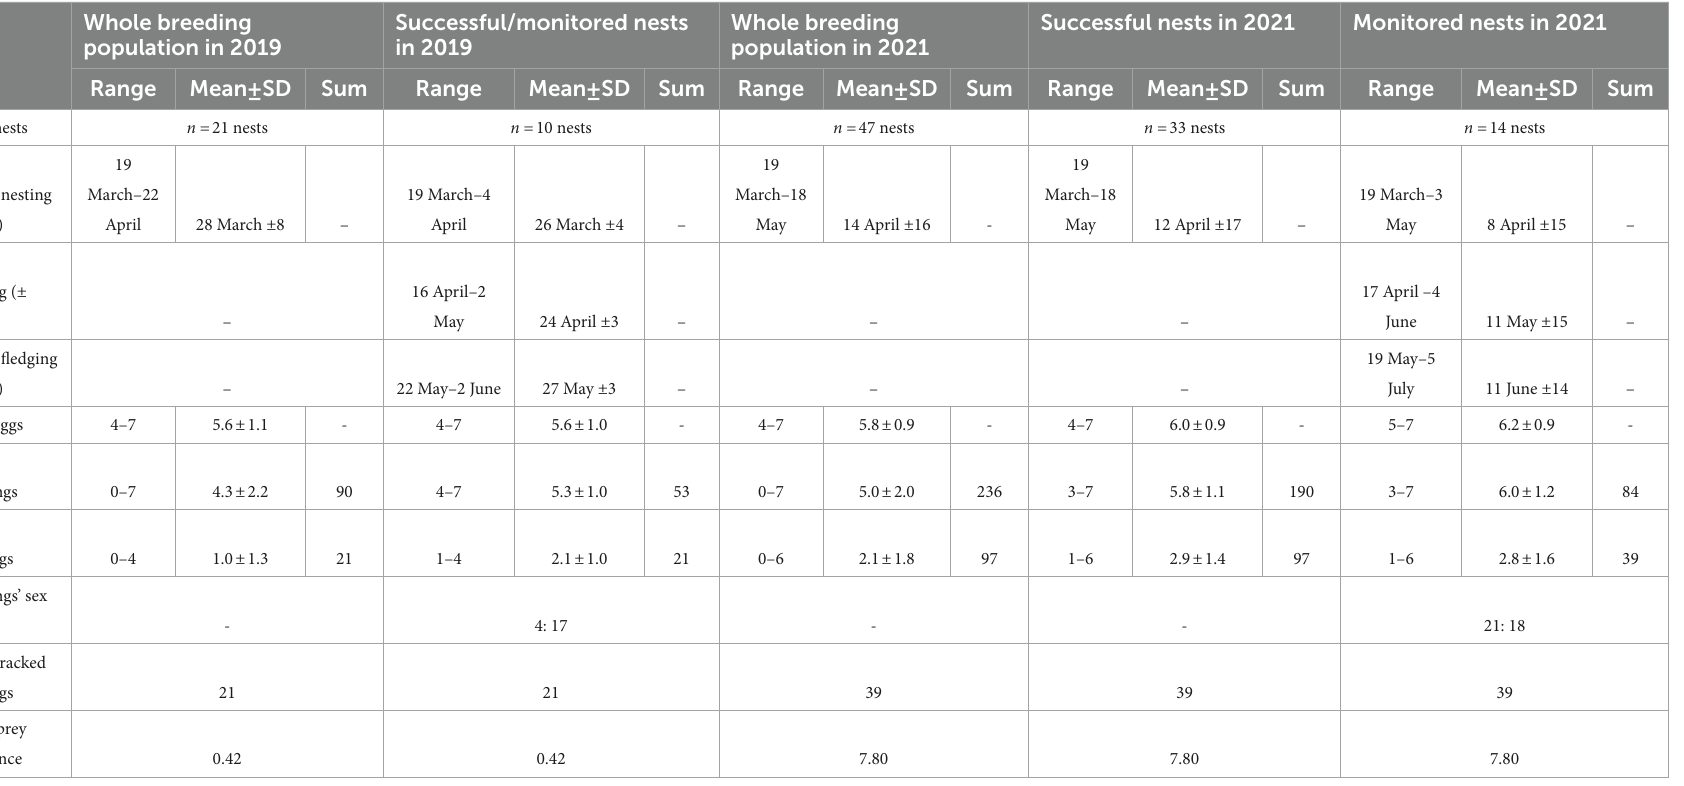
Basic breeding data of the studied population divided into three parts: the whole breeding population, successful nests (the nests with at least one fledgling) and monitored nests (the nest where each fledgling was equipped with a leg-mounted radio transmitter). The mean numbers (± standard deviations) and ranges of nests, clutch sizes, hatchlings, fledglings, radio-tracked individuals, dates of nesting, hatching, and fledging, nestling sex ratios, and spring prey abundance determined by snap-trapping in the study area and listed as the number of trapped individuals per 100 trap-nights recorded during the breeding seasons 2019 and 2021 are